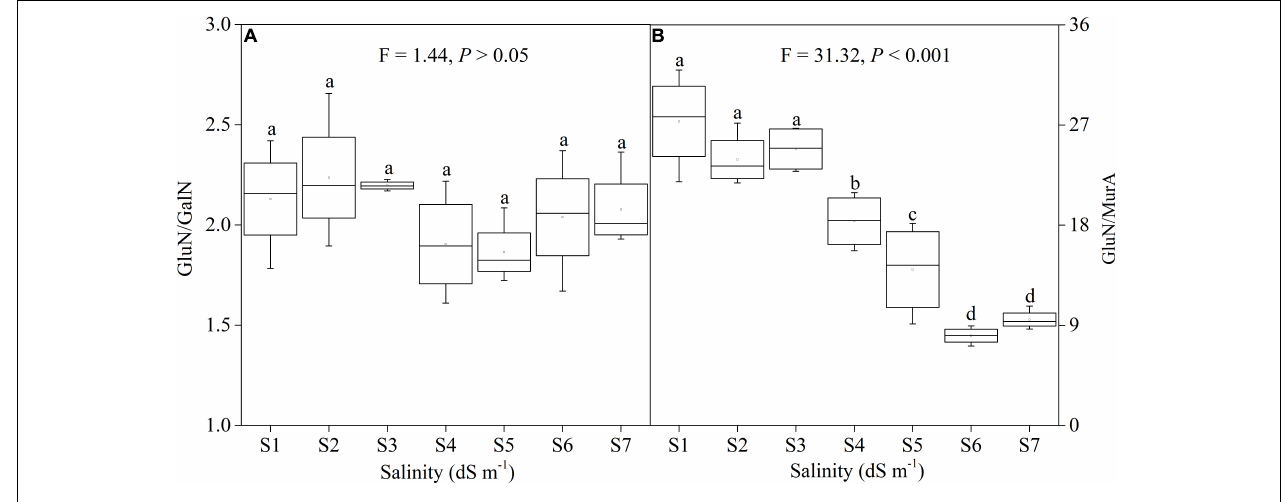
FIGURE 4 | Variation of GluN/GalN (A) and GluN/MurA (B) under different salinity concentrations.